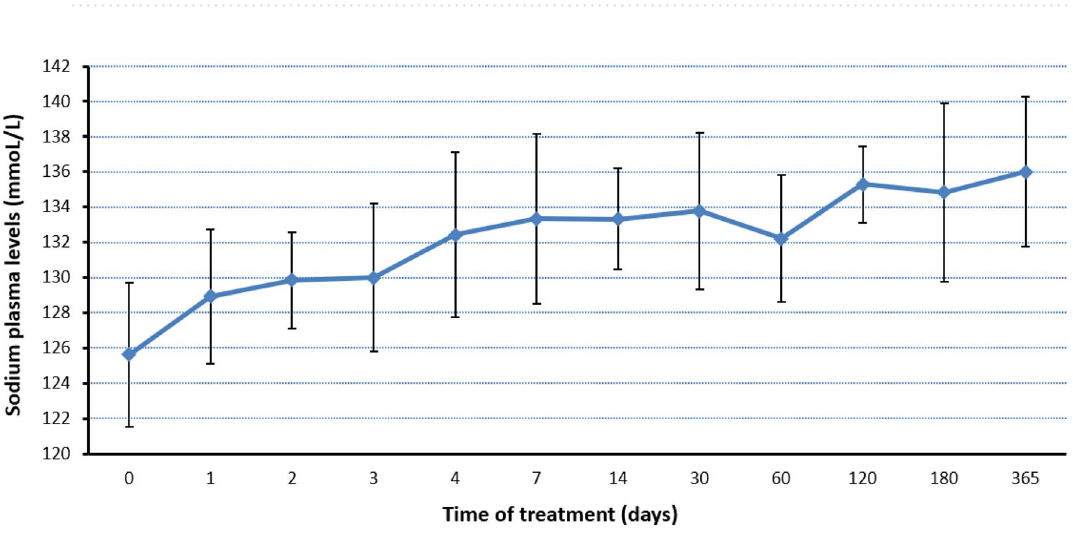
Figure 1. Evolution of sodium levels with urea